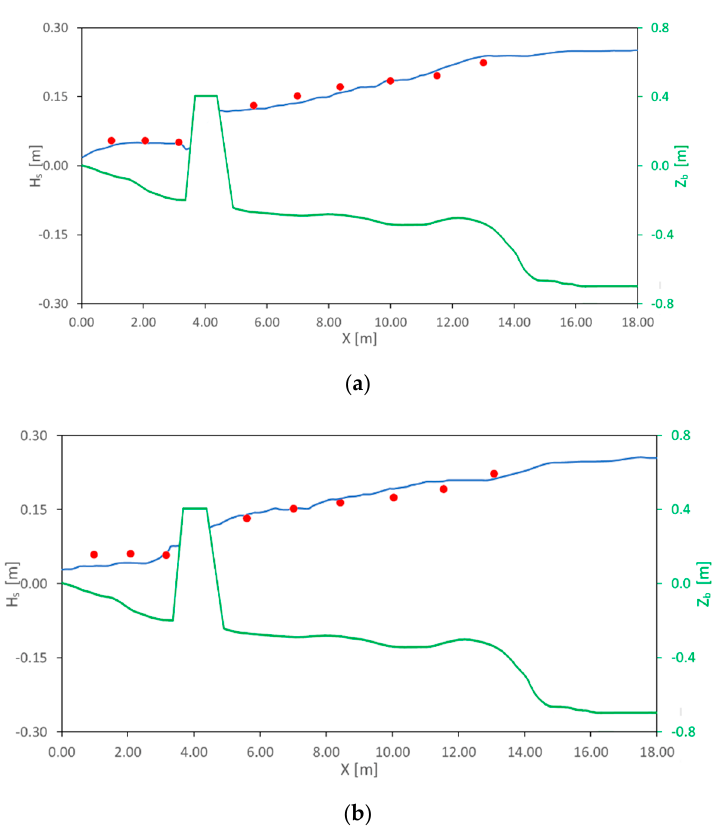
Figure 9. Significant wave height at 𝑌 = 22 m ( a ) and 𝑌 = 26 m ( b ). Blue line: results obtained by the proposed model. Red circles: experimental results obtained by Gravens and Wang [33]. Green line: bottom elevation.